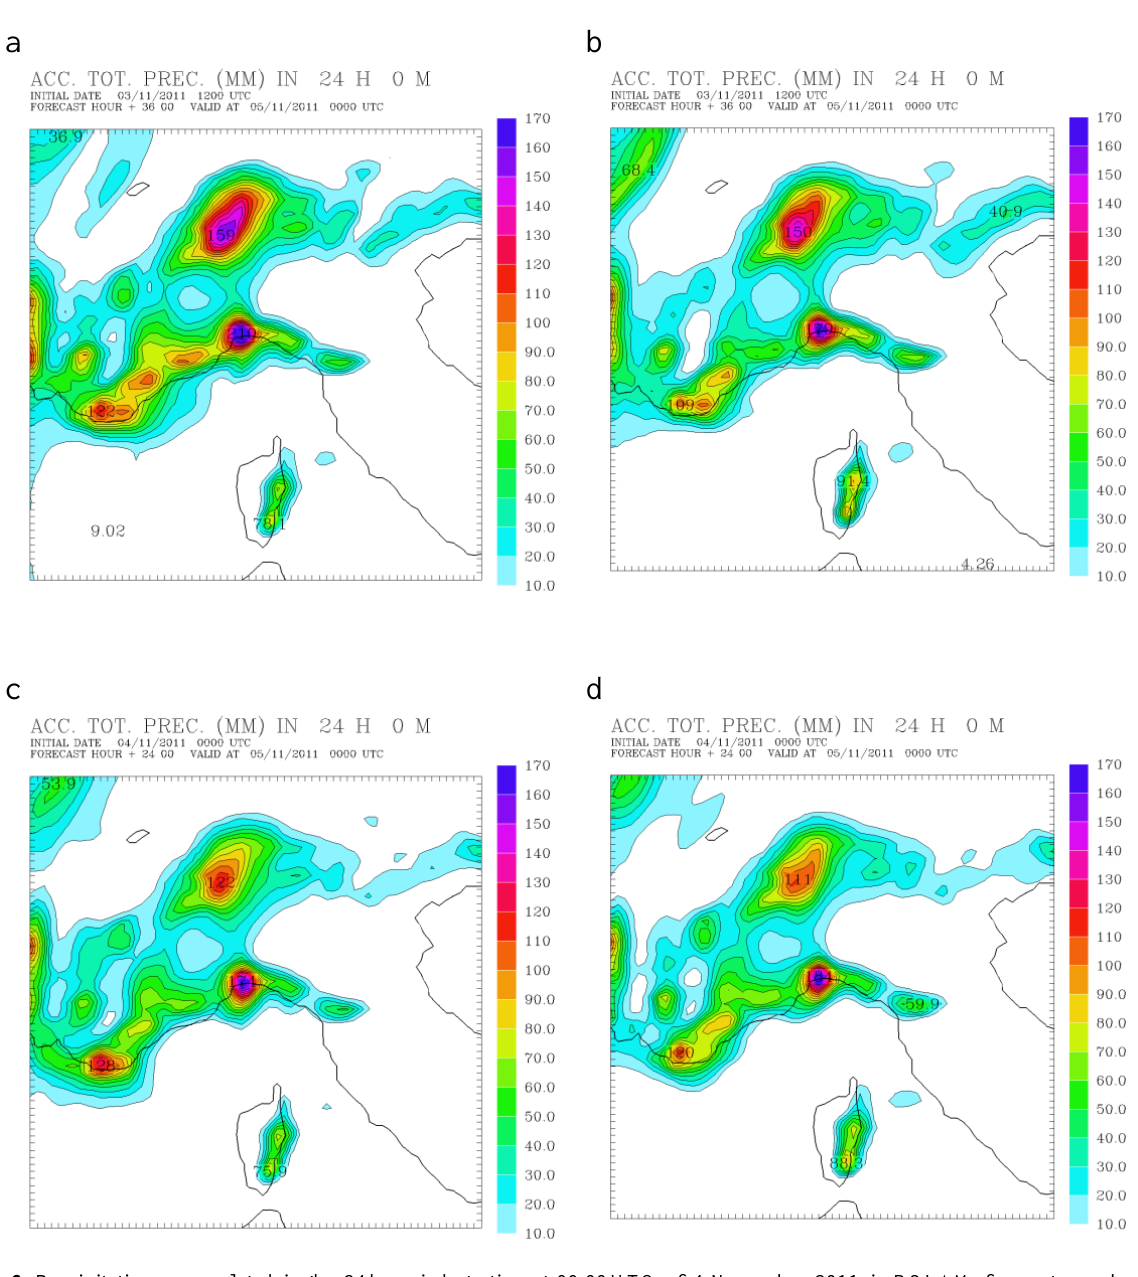
Figure 6. Precipitation accumulated in the 24 hour period starting at 00 UTC of Nov. 4, 2011 in BOLAM forecast runs based on ECMWF-IFS (left column) and NOAA_GFS (right column) analyses. Upper panels: analyses of 12 UTC of Nov 3; lower panels: analyses of 00 UTC of Nov. 4.